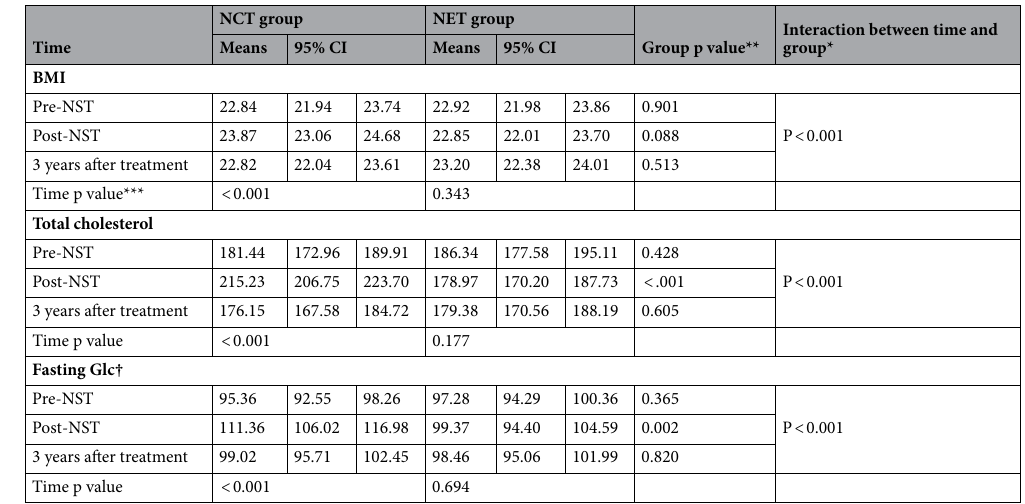
Table 2. Metabolic profile changes after NST and 3 years after the initial treatment. BMI Body mass index, NST Neoadjuvant systemic treatment, NCT Neoadjuvant chemotherapy, NET Neoadjuvant endocrine therapy. *Indicates a significant difference between NCT and NET groups in changes over time. **Comparison between two groups by specific time. ***Significance of changes over time for each